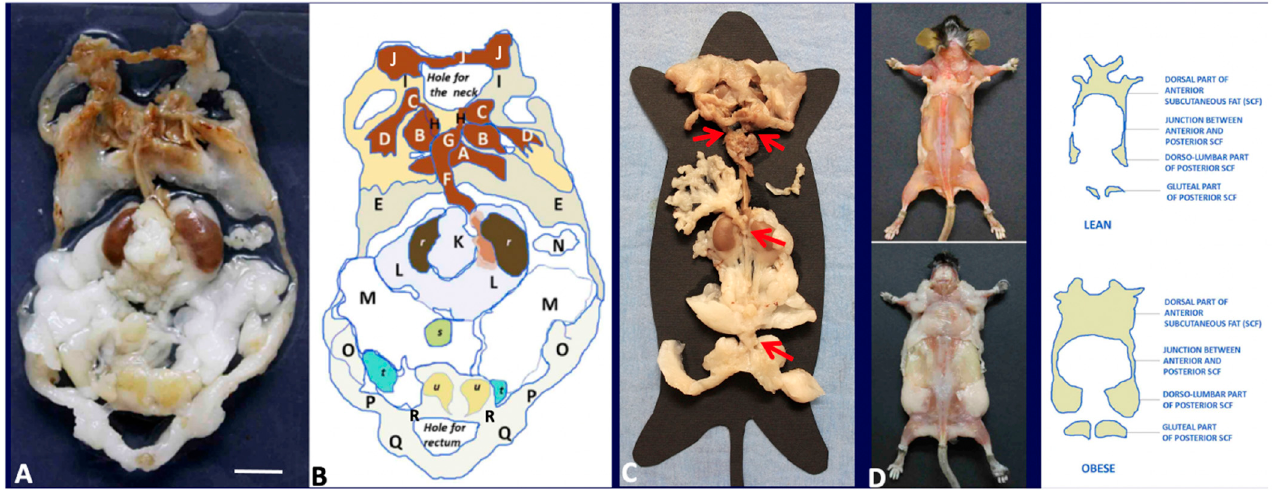
Figure 1. Gross anatomy of mouse adipose organ in different experimental conditions. ( A ): Anatomical preparation of the adipose organ as a unitary structure (adult, male C57BL/6 mouse, normoweight). Subcutaneous ‐ visceral continuities (SVCs) are well visible and indicated in the diagram legend. Preputial glands and kidneys are left to facilitate anatomical orientation. White (WAT) and brown (BAT) adipose tissues are recognizable by their specific colors. ( B ): Legend: A: interscapular BAT (subcutaneous, SC), B: subscapular BAT (SC), C: supraclavicular BAT (SC), D: axillary BAT (SC), E: axillo ‐ thoracic WAT (SC), F and G: periaortic mediastinal BAT (Visceral, V),